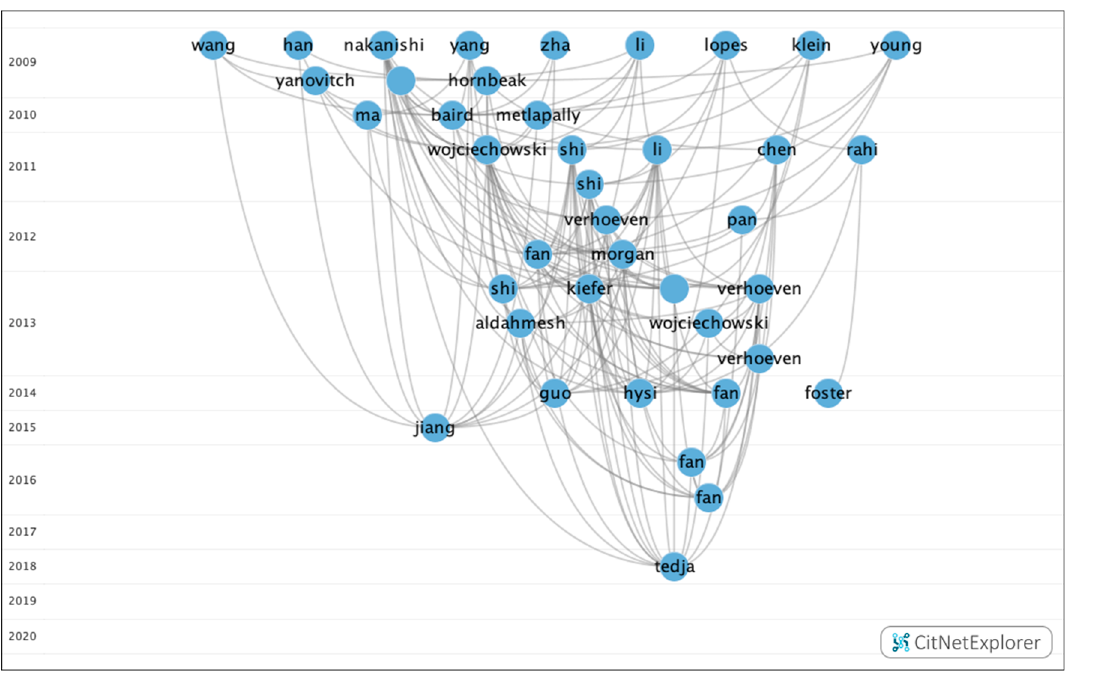
Figure 12. Core publications in citations network about genetic myopia .